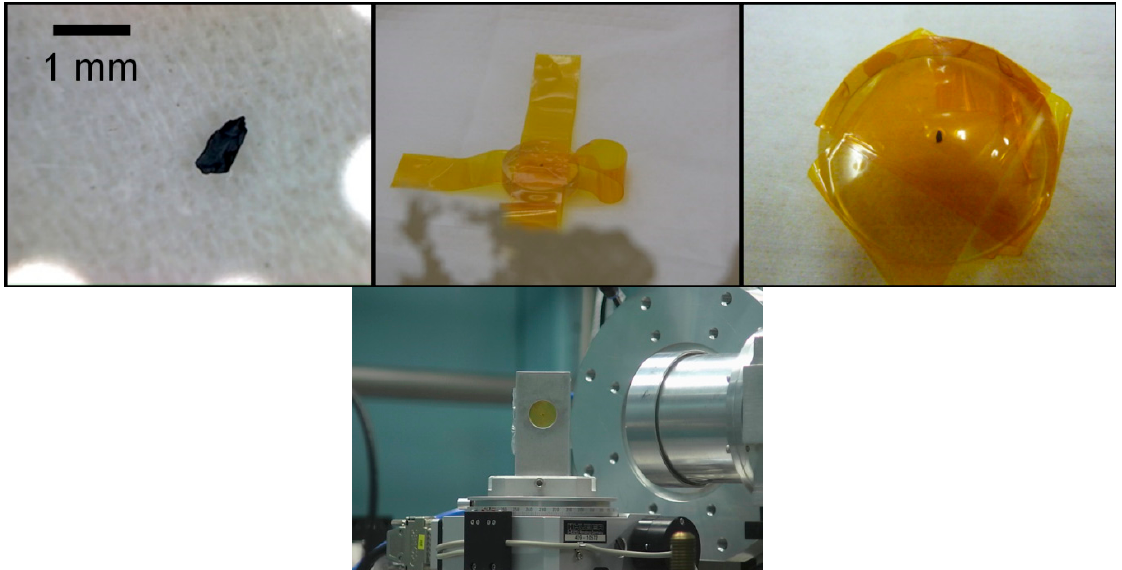
Figure 6. (top from left to right) SNF fragment sampled from irradiated Gösgen PWR fuel rod, fixation inside sample holder, sealed sample holder and (bottom) sample mounted on positioning stage at ACT station in front of the Ge-detector (detector on the right hand side, direction of impinging beam from the left hand side).